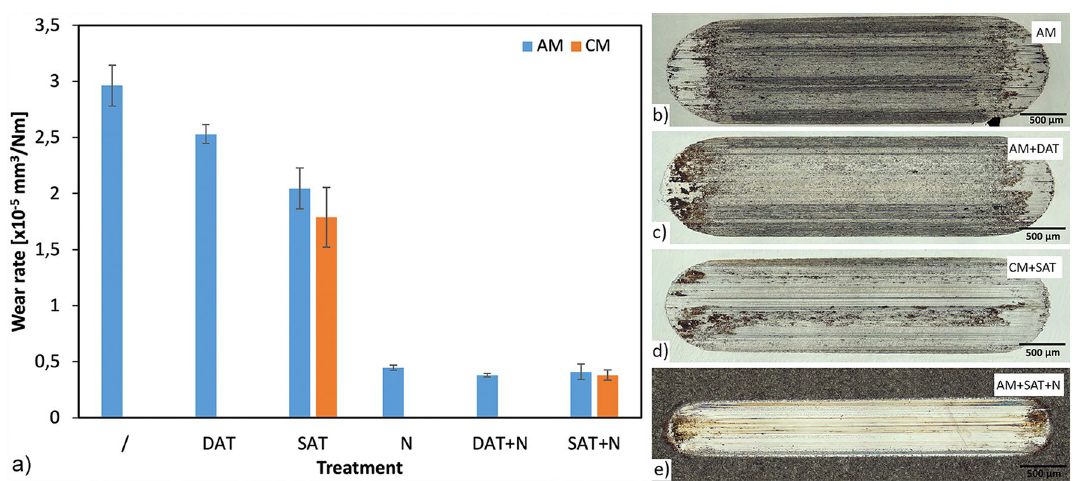
Figure 7. ( a ) Wear rates for the investigated AM and CM maraging-steel specimens and micrographs of the wear tracks of: ( b ) AM, ( c ) AM + DAT, ( d ) CM + SAT and ( e ) AM + SAT + N